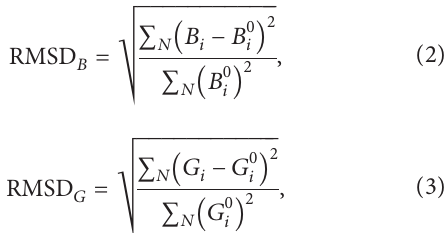
Figure 12: (a) The conductance and (b) the susceptance of 4# PZT under healthy and different breakage